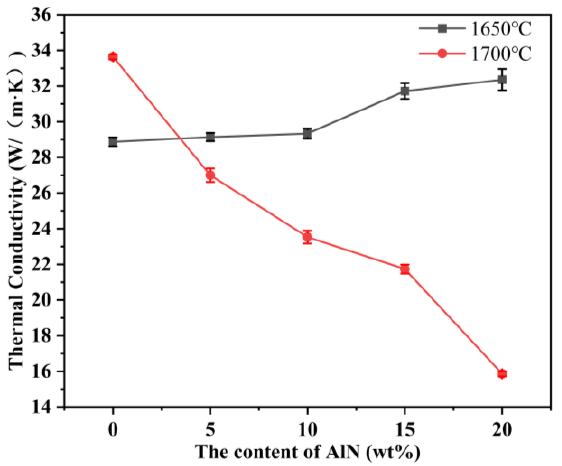
Figure 8. Thermal conductivity of Al 2 O 3 -AlN composites at 1650 °C and 1700 °C